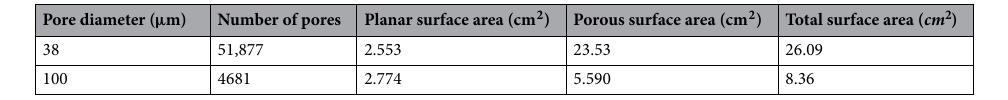
Table 1. Pore geometry and total surface area of REWOD electrode.